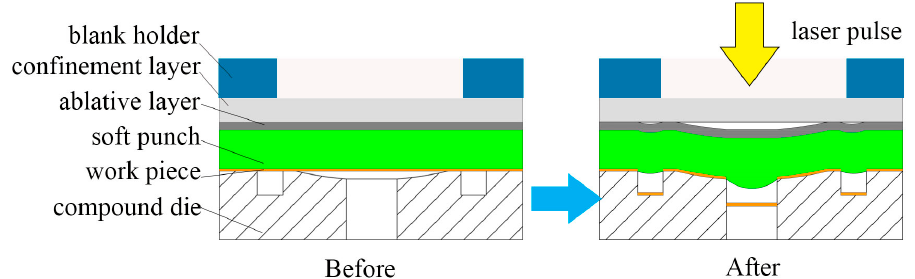
Figure 2. Schematic of the working platform and laser compound